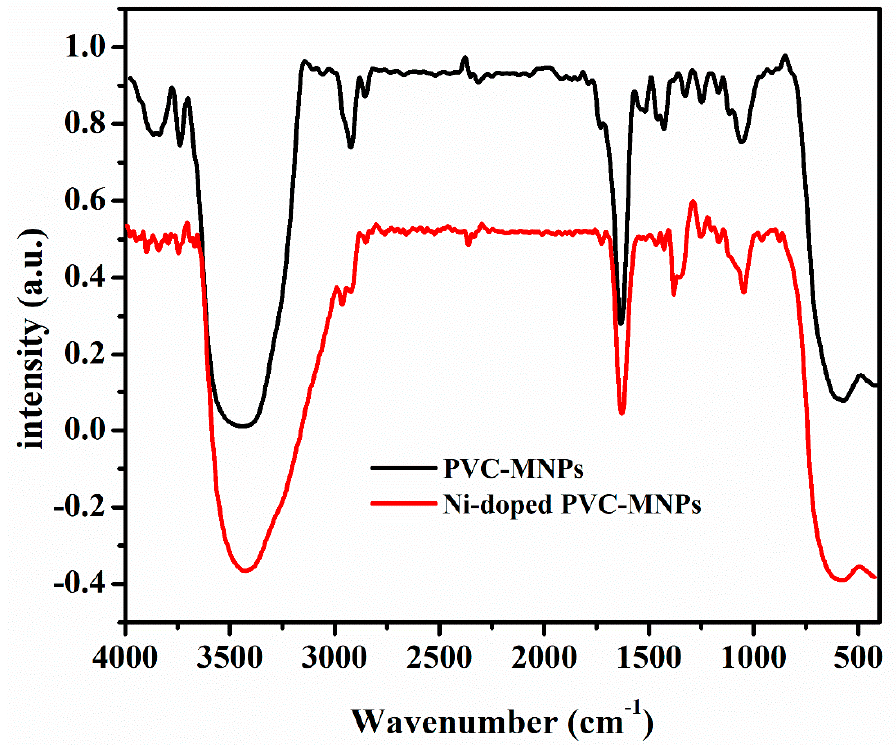
Figure 4. FT-IR spectra of the synthesized PVC–MNPs and Ni-doped Figure 4. FT ‐ IR spectra of the synthesized PVC–MNPs and Ni ‐ doped PVC–MNPs.